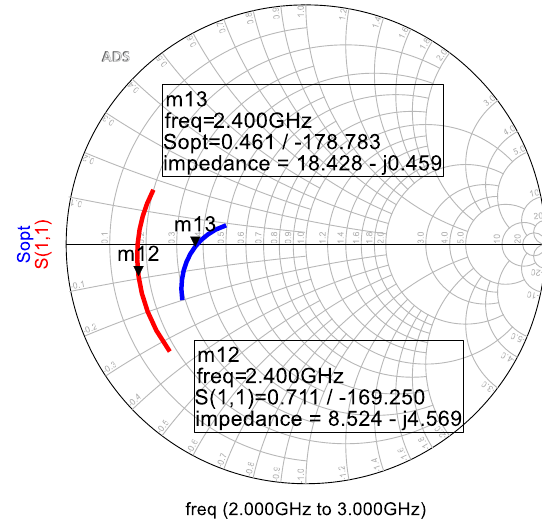
Fig. 7. Input impedance value for (cid:13) (cid:14)(cid:15)(cid:16) and S 11